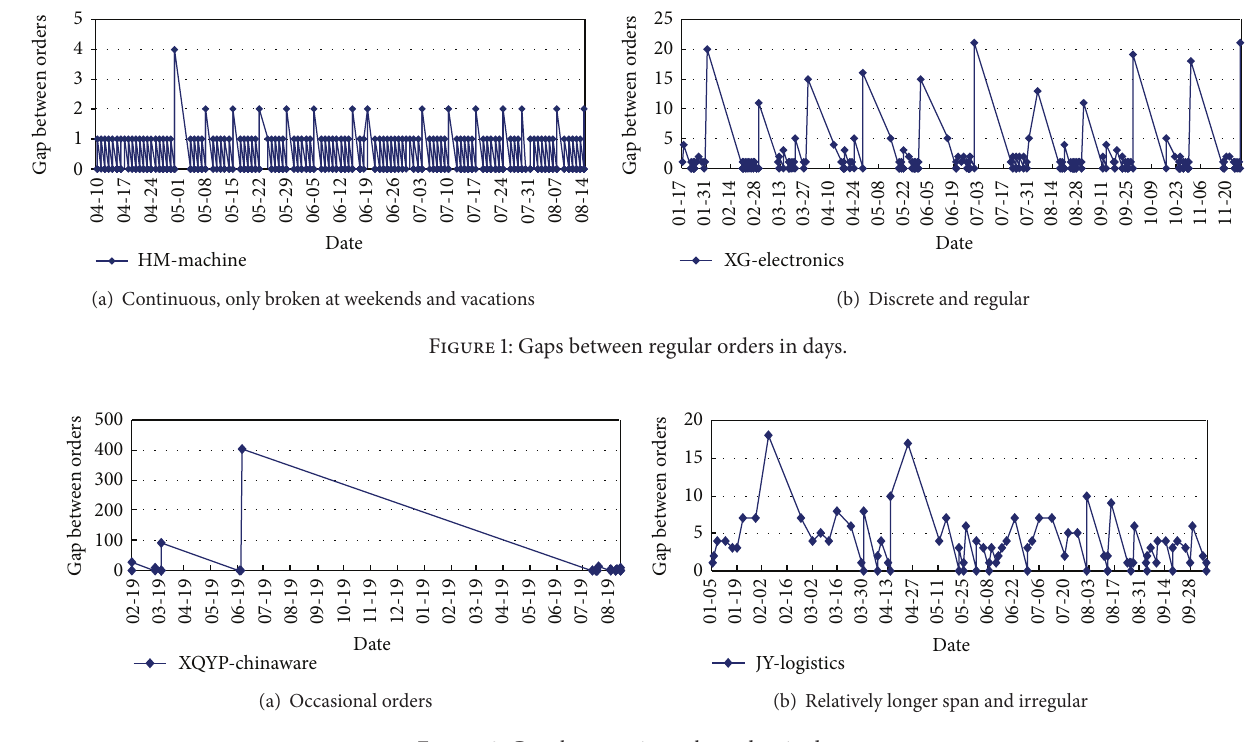
Figure 2: Gaps between irregular orders in days.